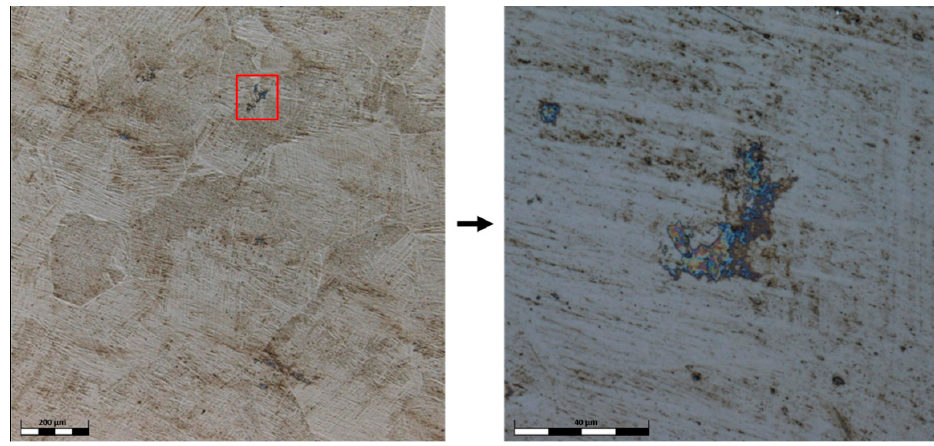
Figure 13. Confocal image of the Ti6Al4V surface after corrosion test.